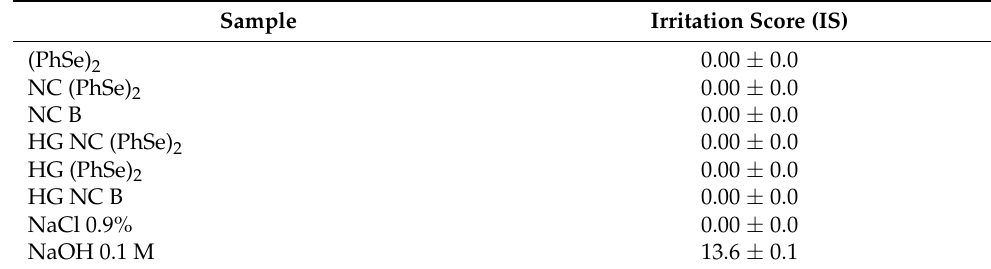
Table 3. Hen’s Egg Test irritation scores.